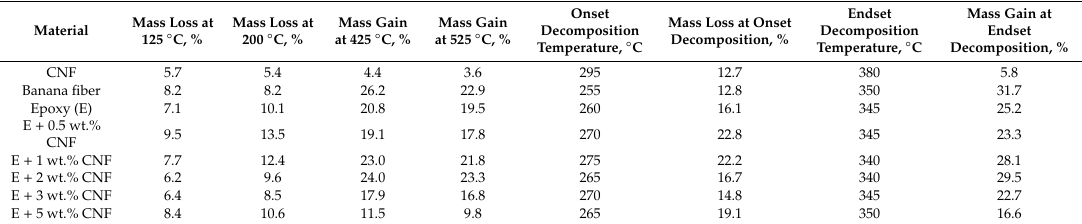
Table 2. TGA properties of unfilled epoxy and CNF-filled epoxy nanocomposites.